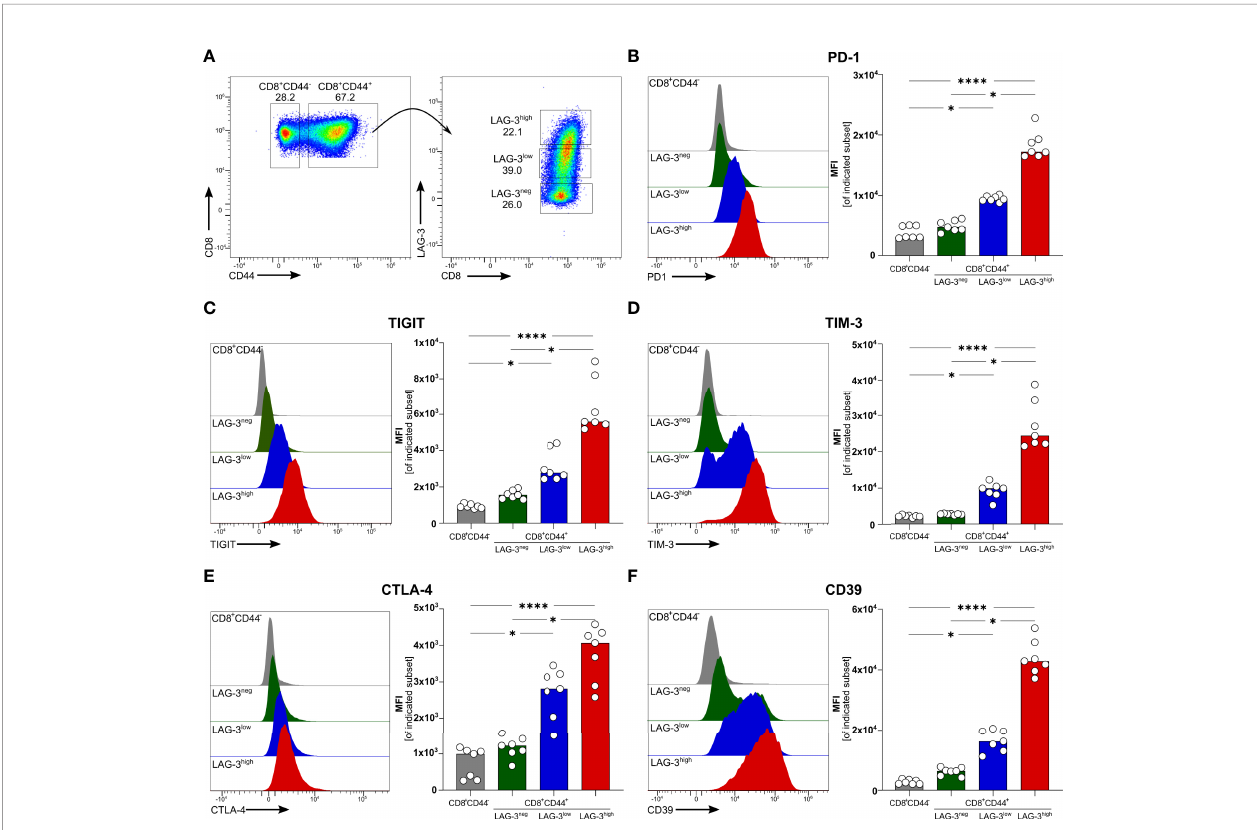
FIGURE 1 | Expression of co-inhibitory molecules and effector molecules correlates with LAG-3 expression. (A) Gating strategy and representative examples of dot plots of LAG-3 expression on CD8 + CD44 + T cells. Representative examples of histograms and summarized median fl uorescent intensity (MFI) of the co-inhibitory molecules (B) PD-1, (C) TIGIT, (D) TIM-3, (E) CTLA-4 and (F) CD39 expressed on CD8 + CD44 + T cells expressing different levels of LAG-3 (CD8 + CD44 + LAG-3 neg , CD8 + CD44 + LAG-3 low , CD8 + CD44 + LAG-3 high ), compared to expression of those markers on CD8 + CD44 - T cells. Data were analyzed with Friedmann ’ s test for multiple comparisons. Each dot represents an individual mouse, n = 7 from two independent experiments. P values between ≤ 0.05 (*) and ≤ 0.0001 (****) were considered statistically signi fi